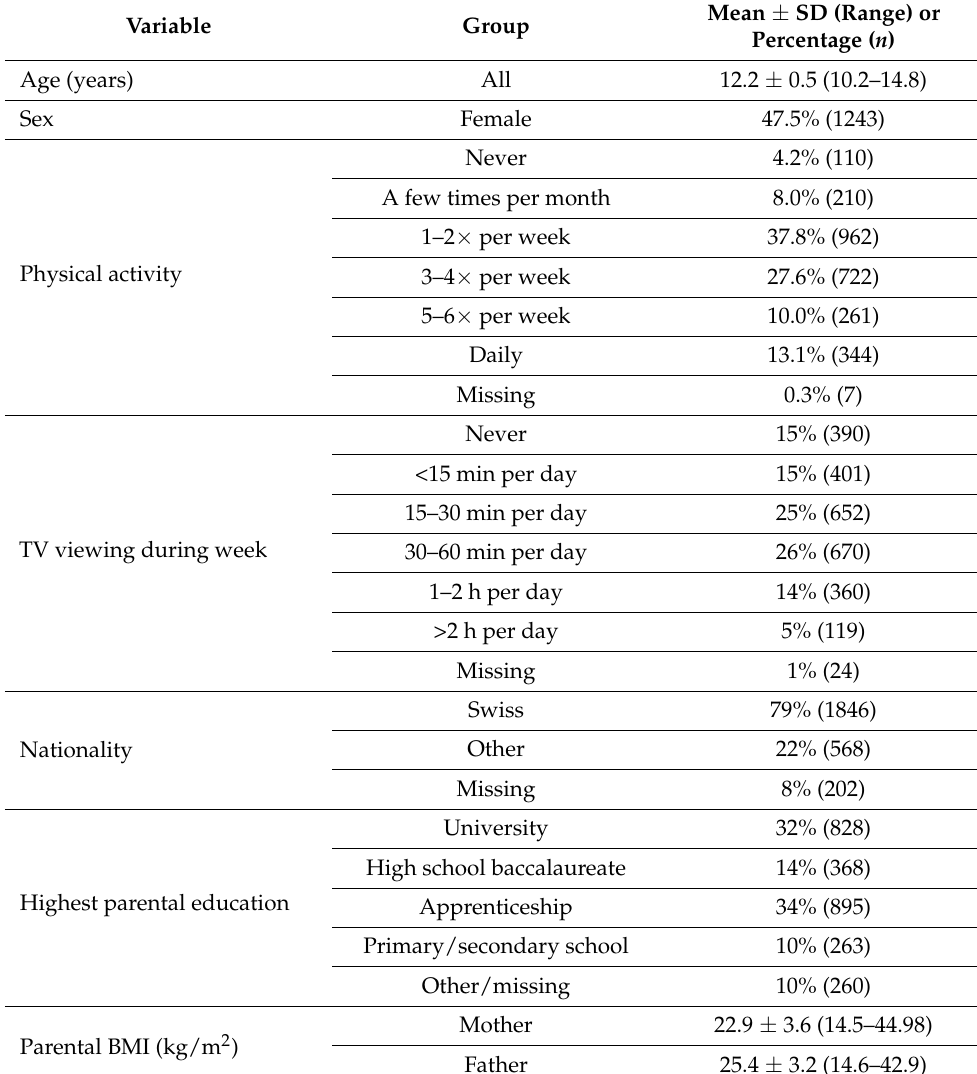
Table 1. Participant characteristics ( n =